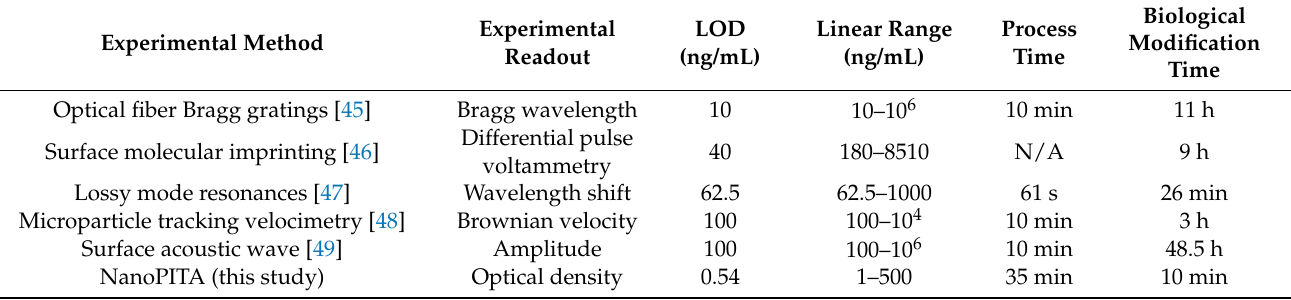
Table 1. Limit of detection, process time and biological modification time of the CRP in various experimental